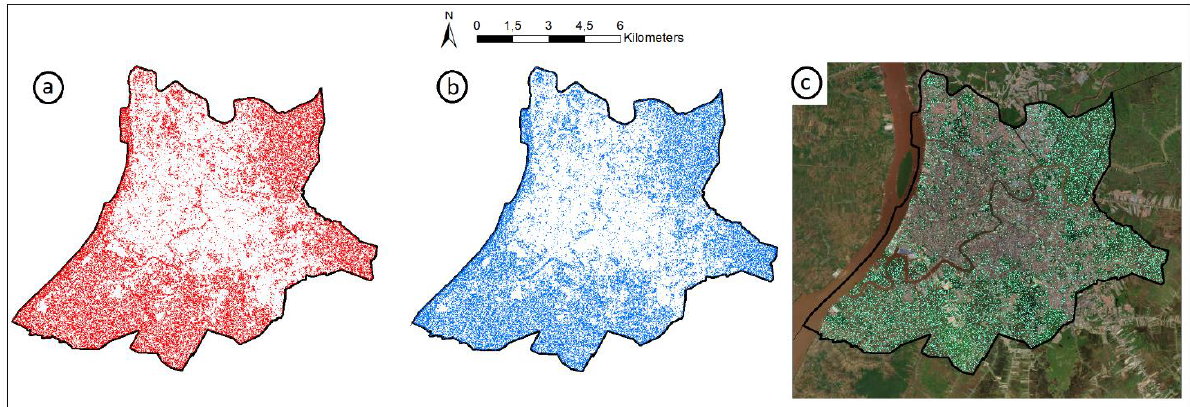
Figure 5 . Coherence results from pre-event and co-event: (a) Pre-event coherence image in Banjarmasin City with values less than equal to 0.3; (b) Co-event coherence image in Banjarmasin City with values less than equal to 0.3; (c) Temporary Surface Water (TSW) Result from Coherence Images.